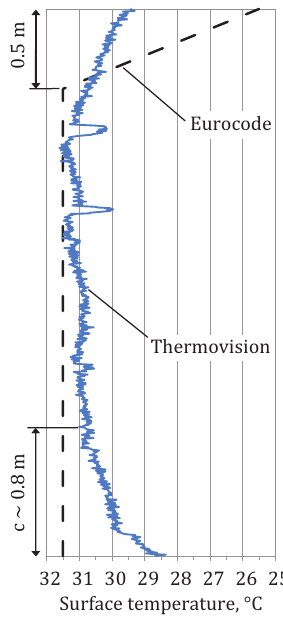
Figure 13. Comparison of testing results with the model from Eurocode based on thermogram of 26 June 2019, time 0:00, in relation to girder chilling